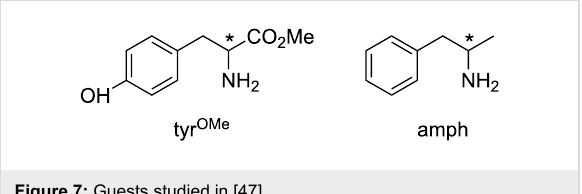
Figure 7: Guests studied in